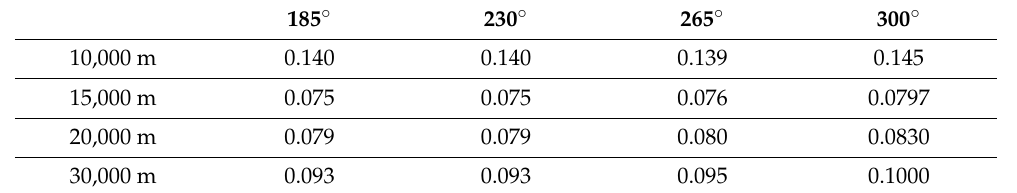
Table A2. Sensitivity test.